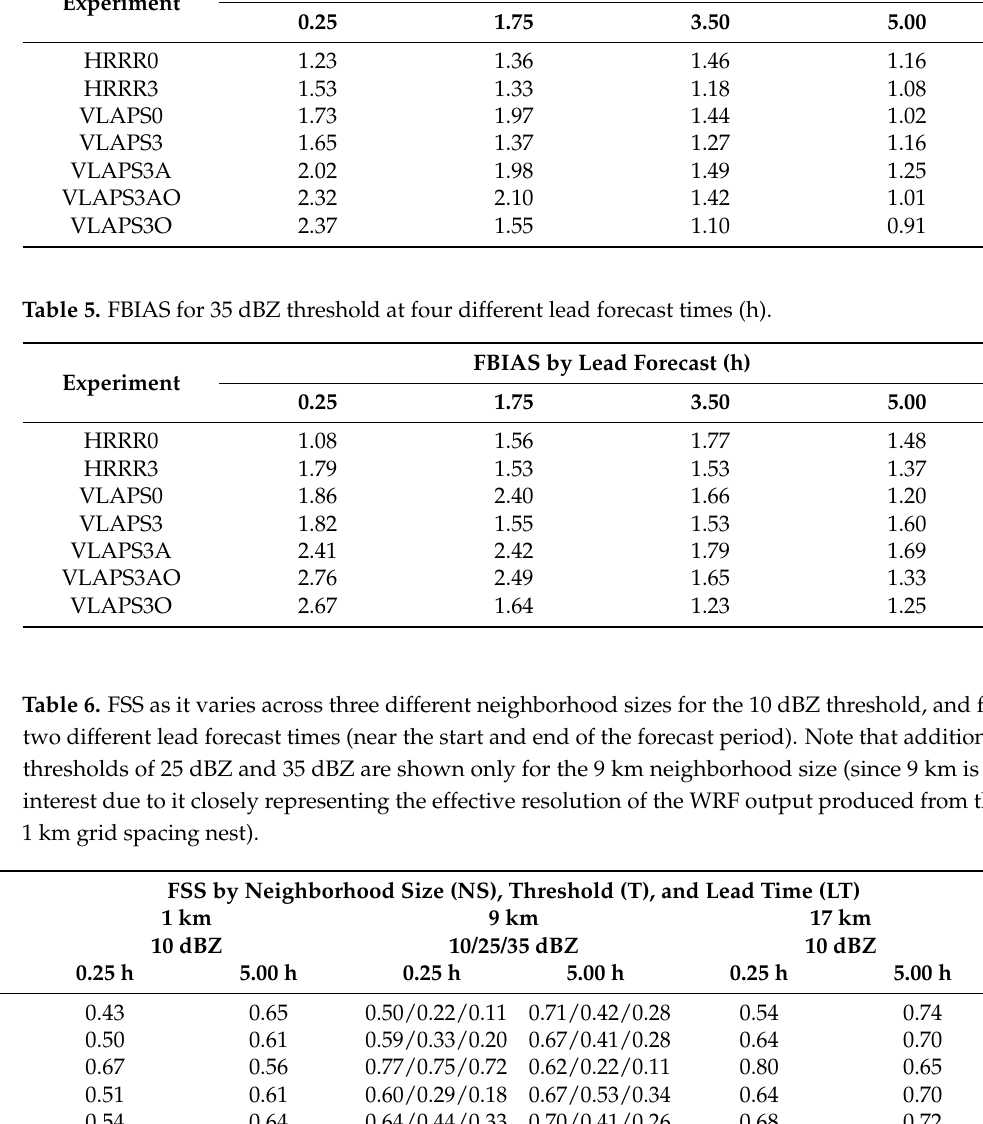
Table 4. FBIAS for 25 dBZ threshold at four different lead forecast times (h). Experiment